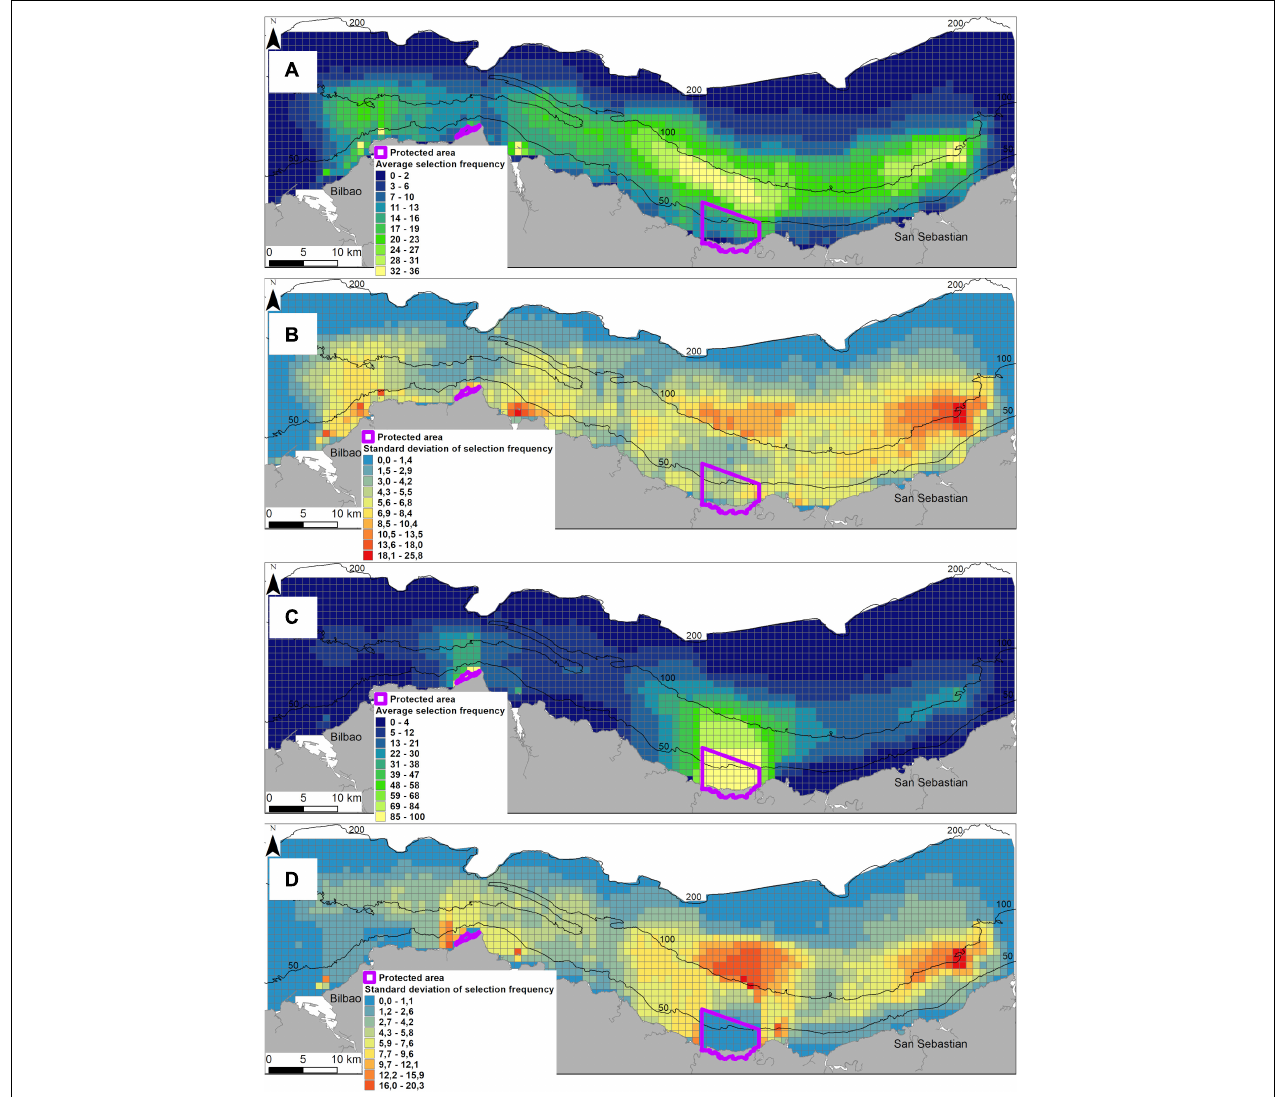
FIGURE 4 | Average and standard deviation of the frequency of selection Planning Units for all scenarios without considering existing Marine Protected Areas (A,B) and considering the existing Marine Protected Areas (C,D)